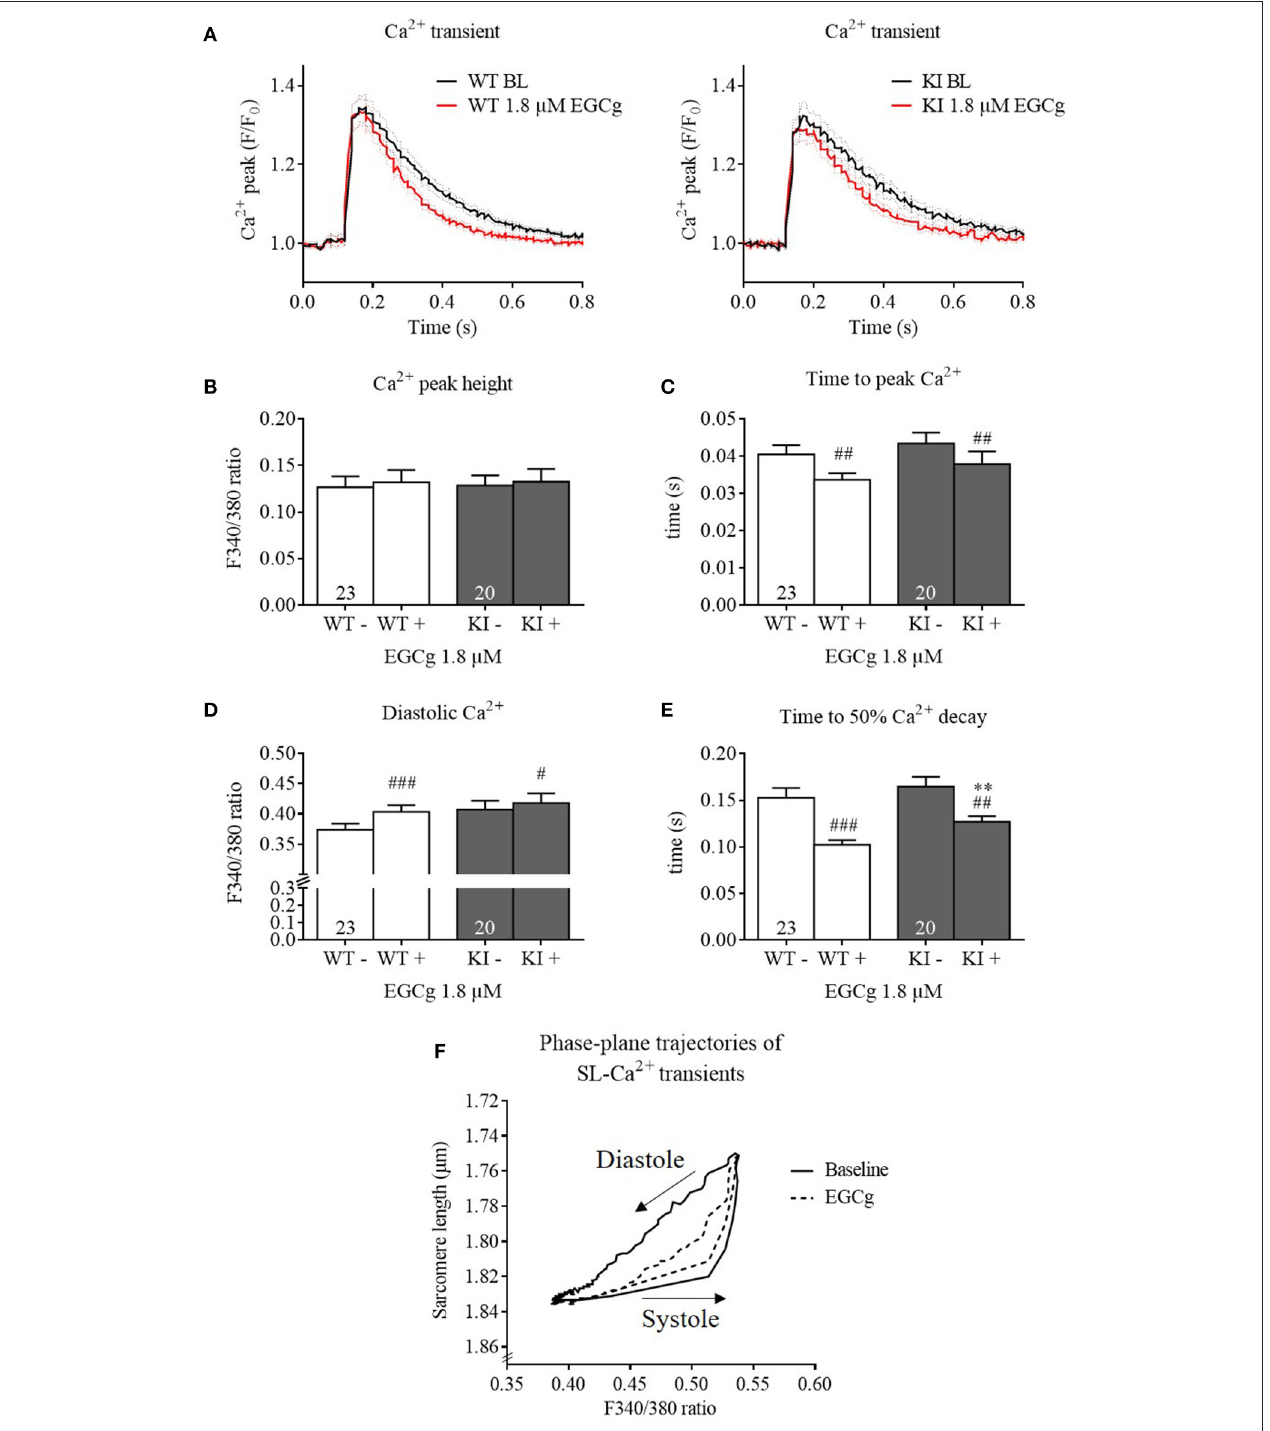
FIGURE 3 | Ca 2 + transients and kinetics of Mybpc3 WT and KI cardiomyocytes before and after treatment with EGCg. After isolation of cardiac myocytes from adult Mybpc3 WT and KI mice, paired (before/after EGCg) measurements of Ca 2 + transients were performed in Fura-2 loaded cells. (A) Averaged Ca 2 + transients of Mybpc3 WT and KI cells in baseline and with EGCg. (B) Ca 2 + peak height, (C) time to peak Ca 2 + (from stimulation to peak of 340/380 ratio), (D) diastolic Ca 2 + , and (E) time to 50% Ca 2 + decay (from peak of 340/380 ratio to 50% decay) were analyzed. (F) Sarcomere length of Mybpc3 WT cells plotted against the Fura-2 signal ratio F340/380 indicating the Ca 2 + transient in the absence (black loop) or presence (dotted black loop) of 1.8 µ M EGCg, respectively. Loops proceed in a counter-clockwise direction. ** P < 0.01 vs. WT in the same condition, unpaired Student‘s t -test; # P < 0.05, ## P < 0.01 and ### P < 0.001 vs. baseline, paired Student‘s t -test, n = 20–26, N = 5. For loops: n = 9.